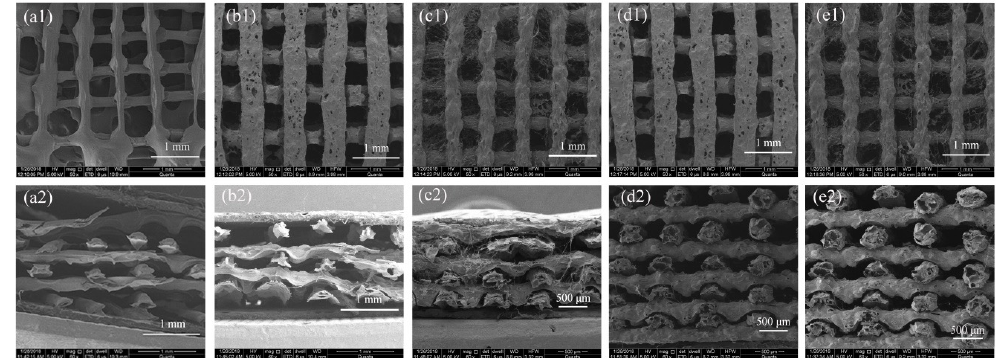
Figure 3. Morphological characterization of 3D printed hydrogels. Scanning electron microscope (SEM) micrographs of hydrogel prepared with 3D printing ink: ( a1 , a2 ) Al1Ch0; ( b1 , b2 ) Al1Ch0.2;